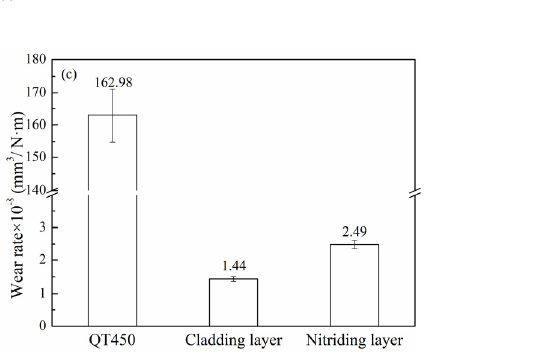
Figure 4. ( a ) Friction coefficient, ( b ) wear depth, and ( c ) wear rates of substrate, cladding layer, and nitriding layer under dry sliding conditions.